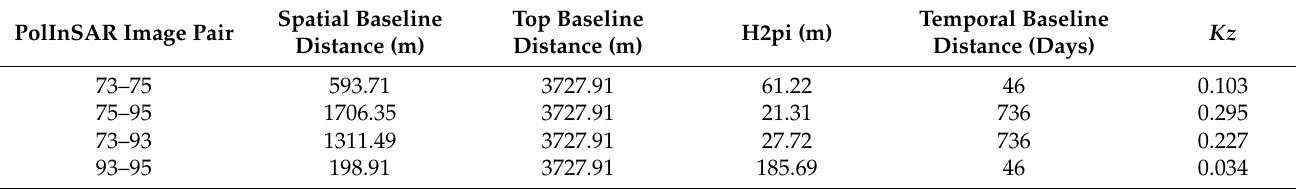
Table 2. The list of baselines of four ALOS/PALSAR image